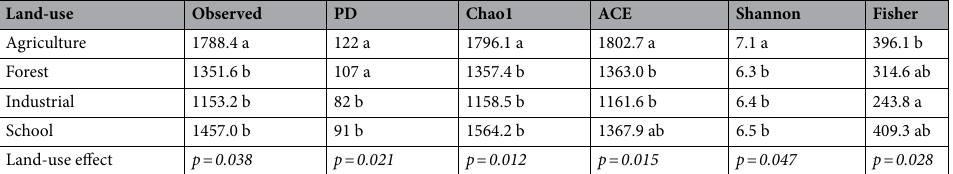
Table 1. Comparison of bacterial α-diversity indexes among different land-use management samples. Different letters indicate statistically significant differences between the means at p <